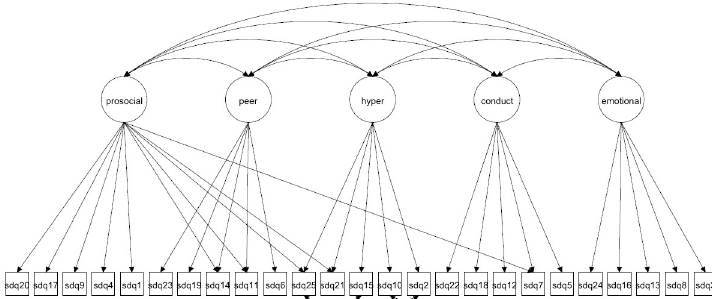
Fig 14. 5-factor model with cross-loadings and correlated errors for minor factors (Model 8a). https://doi.org/10.1371/journal.pone.0265481.g014 illicit substances 40 or more times), leaving a study sample of n = 5549 (50.5% females). There were low rates of missing values on the SDQ items, ranging from n = 19 (0.34%) for SDQ1 to n = 74 (1.33%) for SDQ14. Given the low prevalence of missing values, we did not consider imputing the missing values.